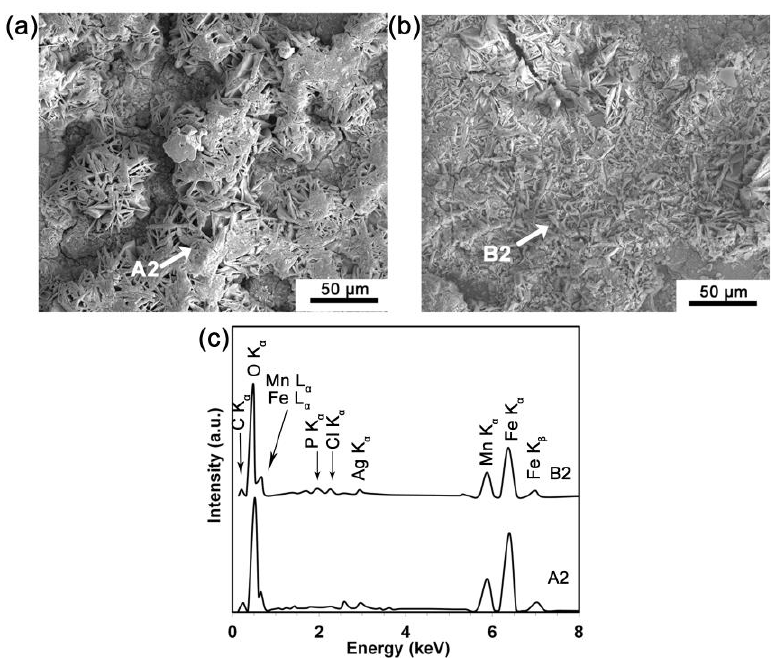
Figure 6. The surface of the degraded samples after a 14-day immersion in MHBSS ( a ) MP and ( b ) PT sample, and ( c ) EDS for points A2 in ( a ) and B2 in ( b ).